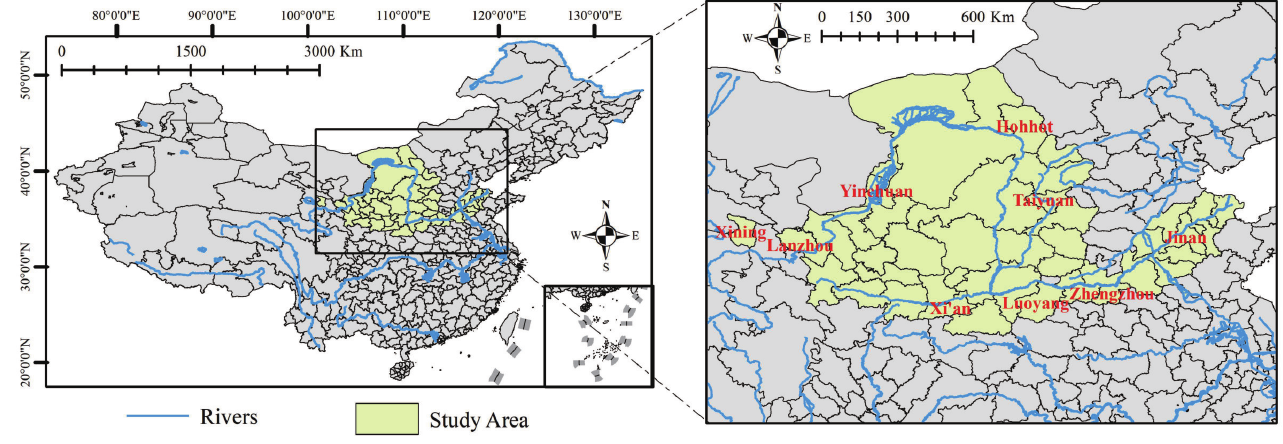
Figure 1. Map of of cities in the Yellow River Basin (YRB) in the current